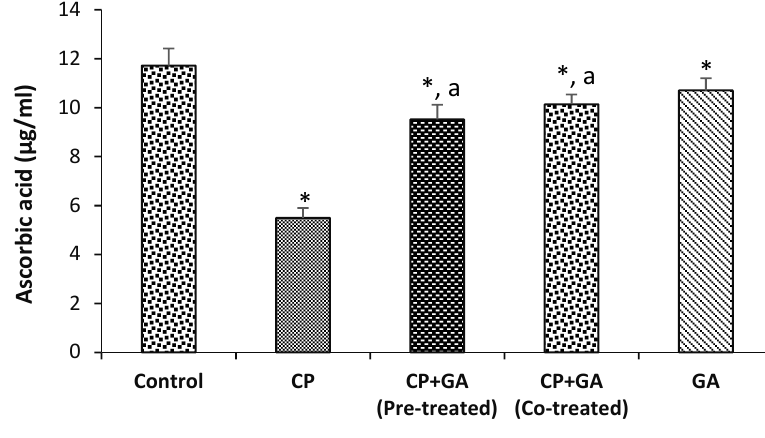
Figure 3. Protective effects of gallic acid on cyclophosphamide induced changes in the levels of hepatic ascorbic acid in rats. CP = cyclophosphamide (2 mg/kg body weight); GA = gallic acid (20 mg/kg body weight); Data are expressed as mean ±SD for five rats in each group; * Significantly different from the control ( p < 0.05); a Significantly different from cyclophosphamide group.